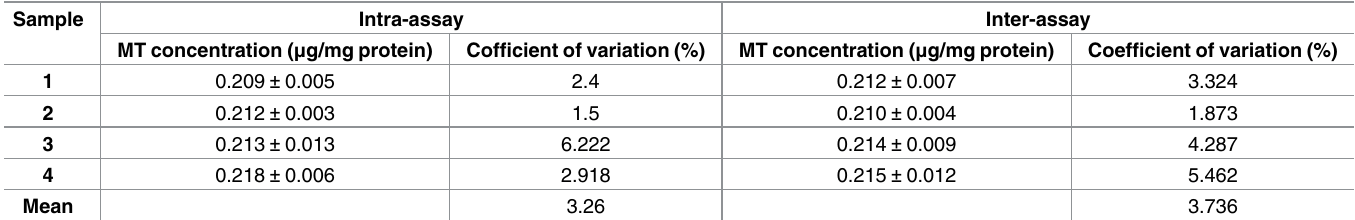
Table 7. The MT contents in the hepatopancreas of Sinopotamon yangtsekiense . Sample MT concentration ( μ g/mg